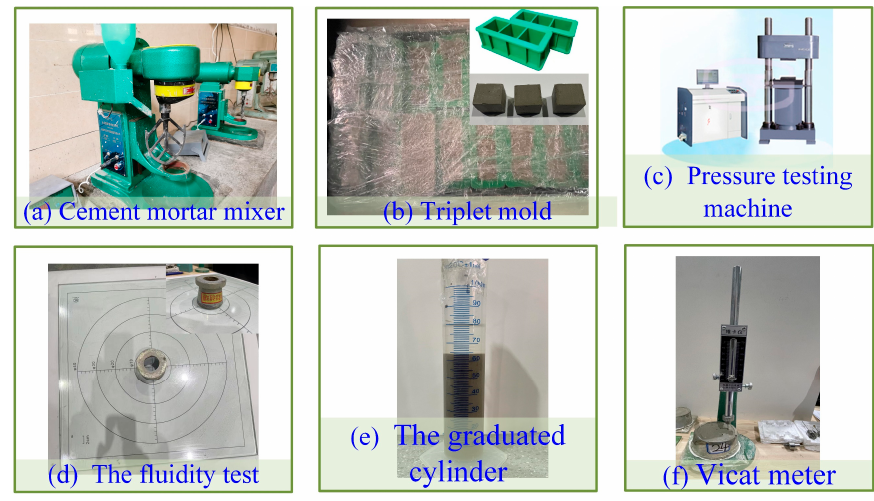
Figure 6. Test Figure 6. Test instruments.